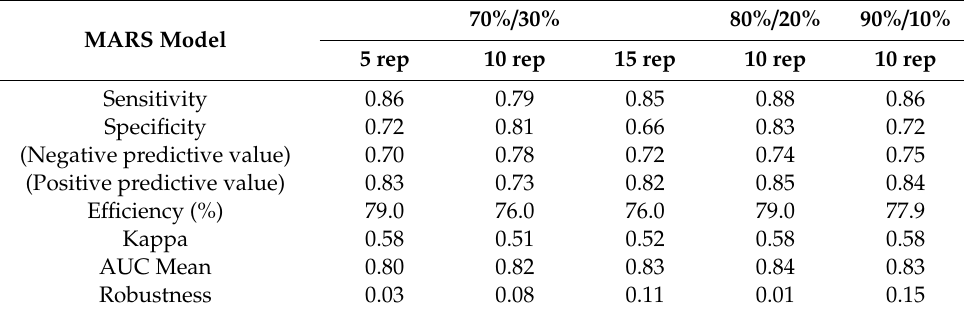
Table 5. Forecasting e ffi ciency of the model given 10 data